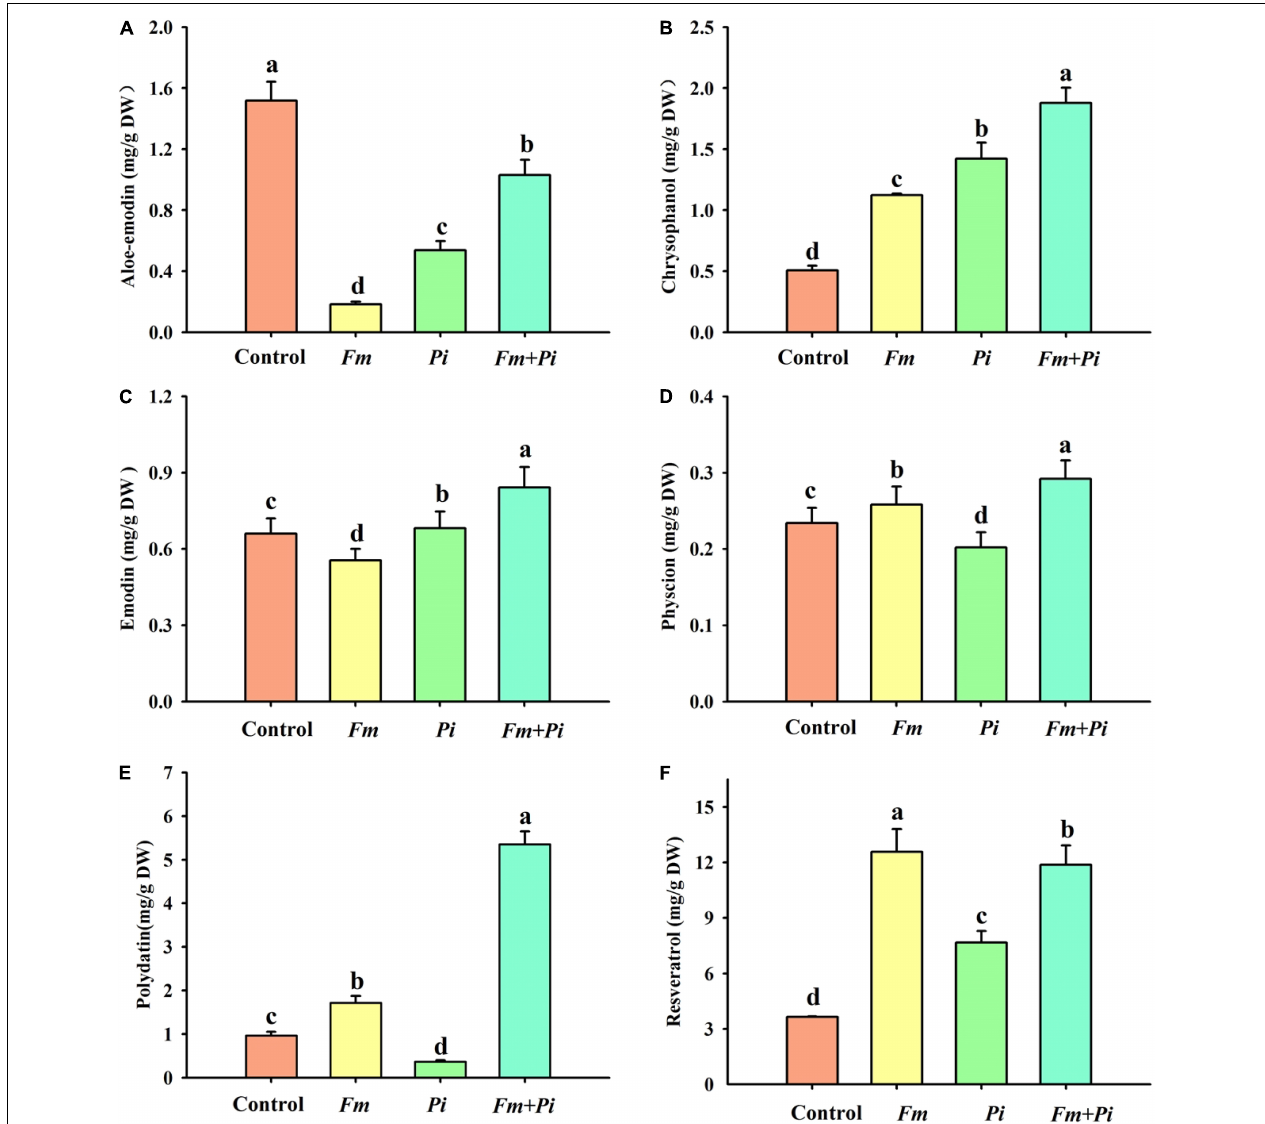
FIGURE 3 | Effects of Funneliformis mosseae ( Fm ) and Piriformospora indica ( Pi ) single or in combination on root aloe-emodin (A) , chrysophanol (B) , emodin (C) , physcion (D) , polydatin (E) , and resveratrol (F) contents of Polygonum cuspidatum Sieb. et Zucc. Data (means ± SD , n = 3) followed by different letters above the bars indicate significant ( p < 0.05) differences between